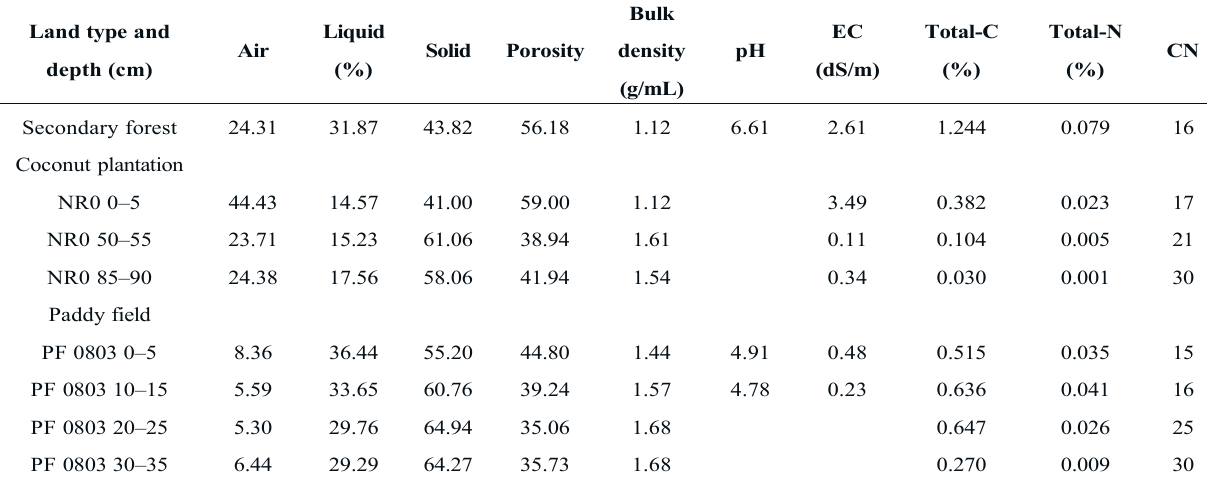
Table 4. Physical and chemical characteristics of soils/sediments collected from terrestrial and mangrove